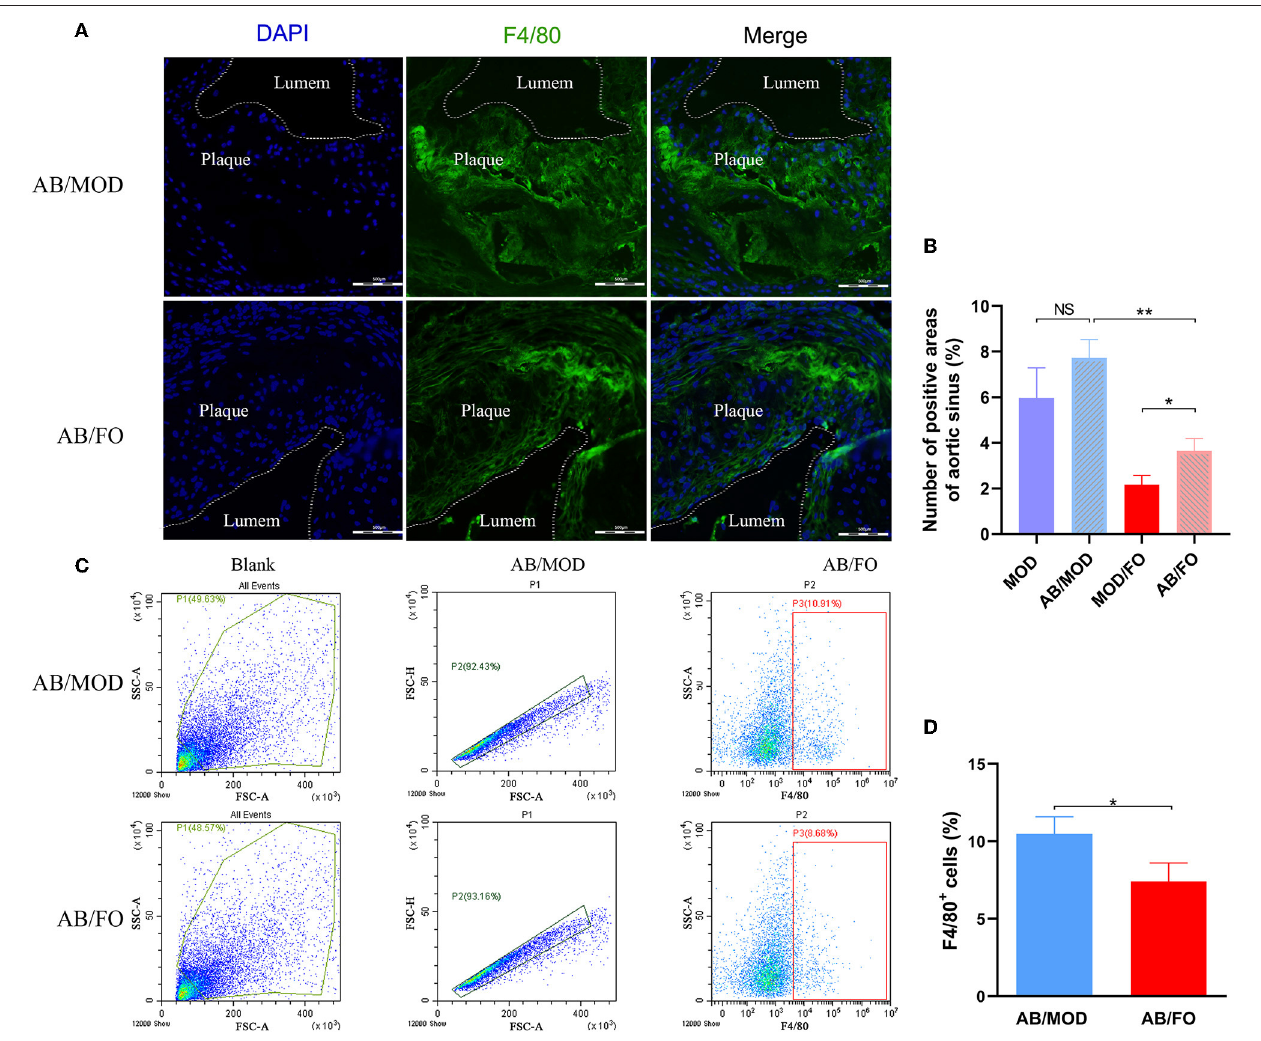
FIGURE 8 | ALA-rich FO inhibited inflammatory M ψ in atherosclerosis by flow cytometry and Immunofluorescence in antibiotic (AB)-treated mice. (A) Detection of M ψ by PE conjugated F4/80 + antibody. (B) F4/80 + cells in immunofluorescence image. In flow cytometry, quantitative analysis as F4/80 + cells (C) . In immunofluorescence assay, quantitative analysis as F4/80 + cells (D) . Values are given as mean ± SEM. * P < 0.05, ** P <